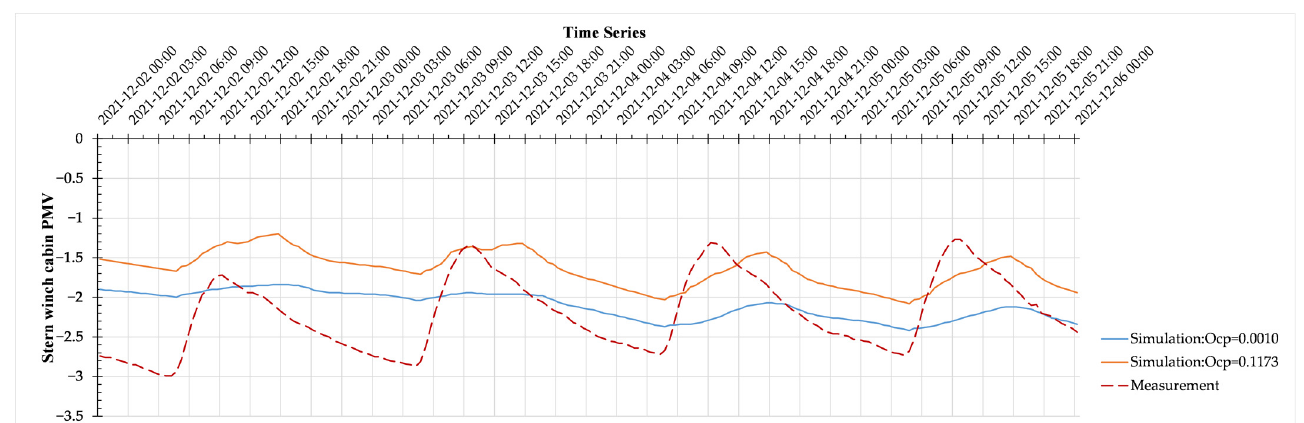
Figure B4. Stern winch cabin: predicted percentage dissatisfied between 2 and 5 December 2021.